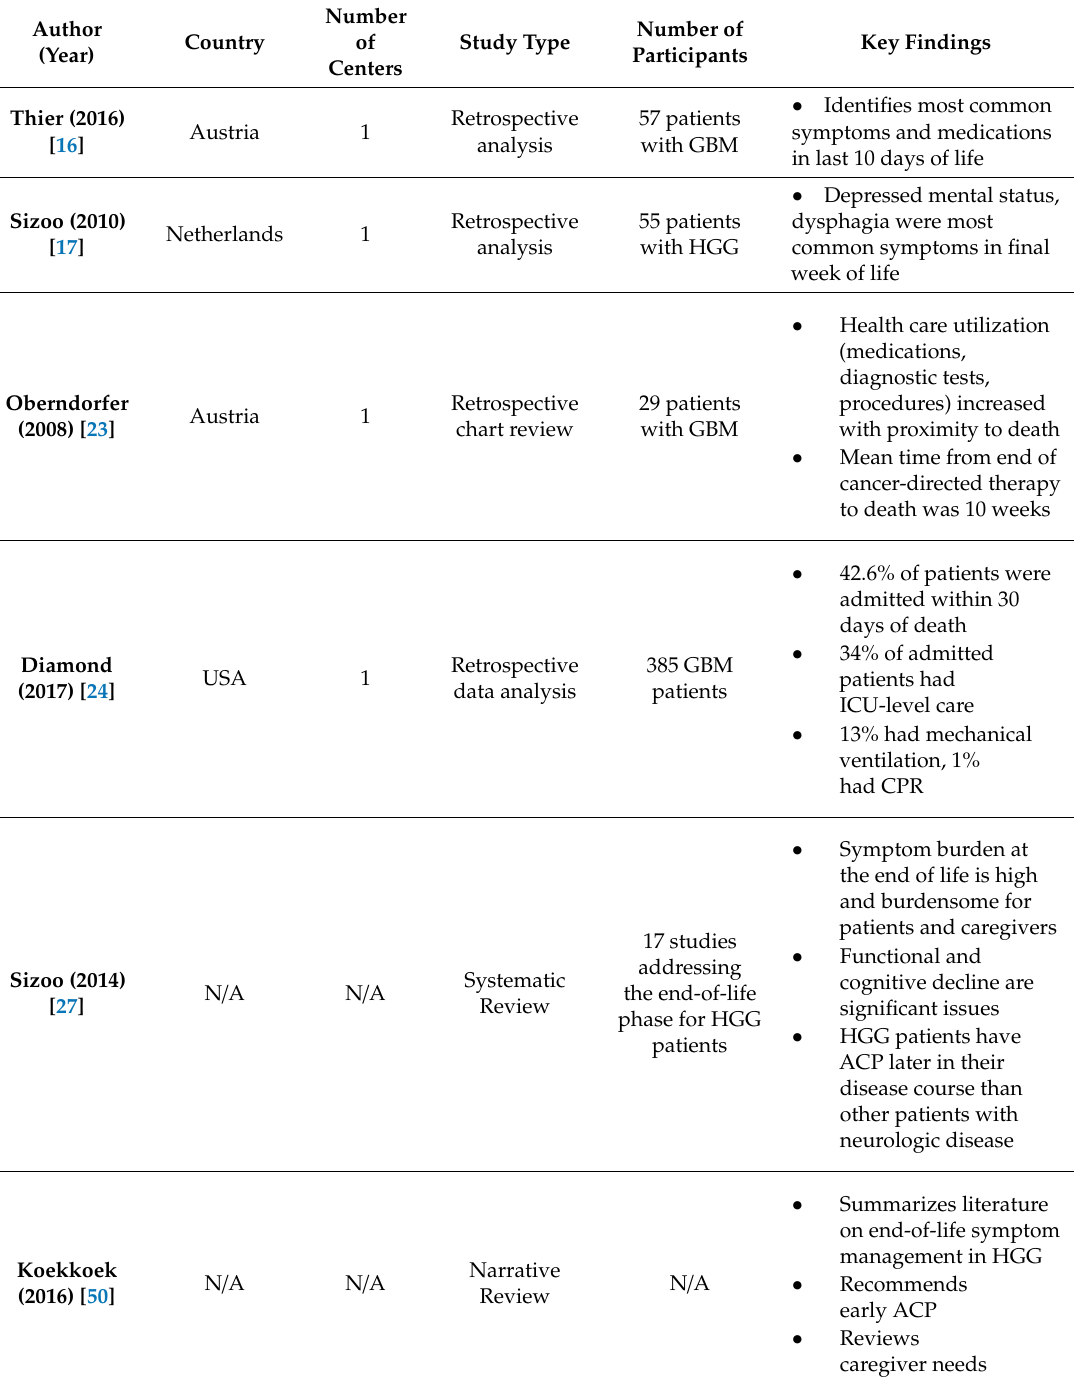
Table 2. Summary of the literature on end-of-life supportive care needs and health care utilization in HGG.